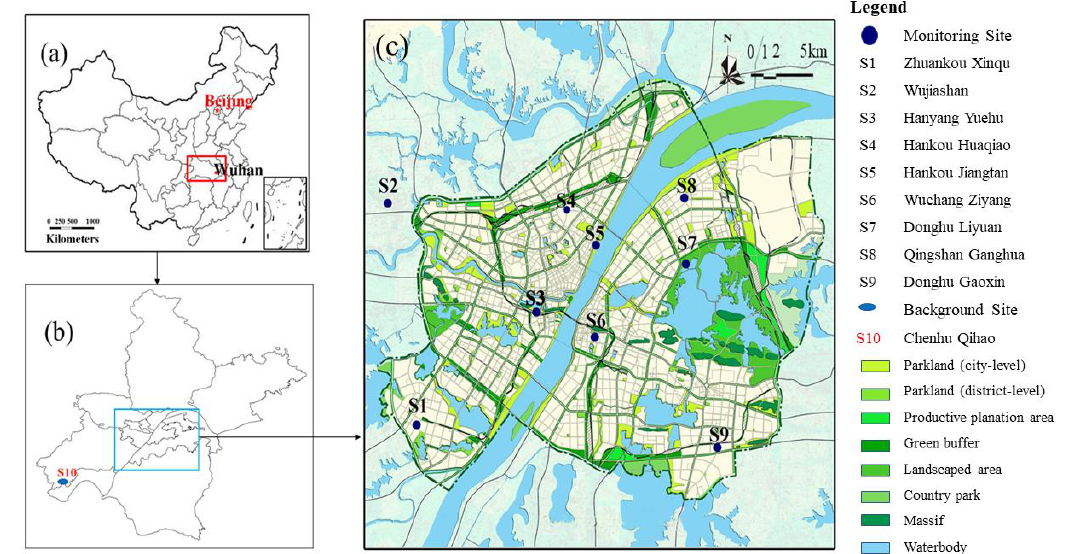
Figure 1. Locations of national-controlling ambient air quality monitoring sites in Wuhan: ( a ) location of Wuhan in China; ( b ) administration boundary of Wuhan and spatial distribution of nationally controlled ambient air quality monitoring sites, (S10 is Chenhu Qihao (background site)); ( c ) detailed monitoring site locations on the land-use map of Wuhan urban